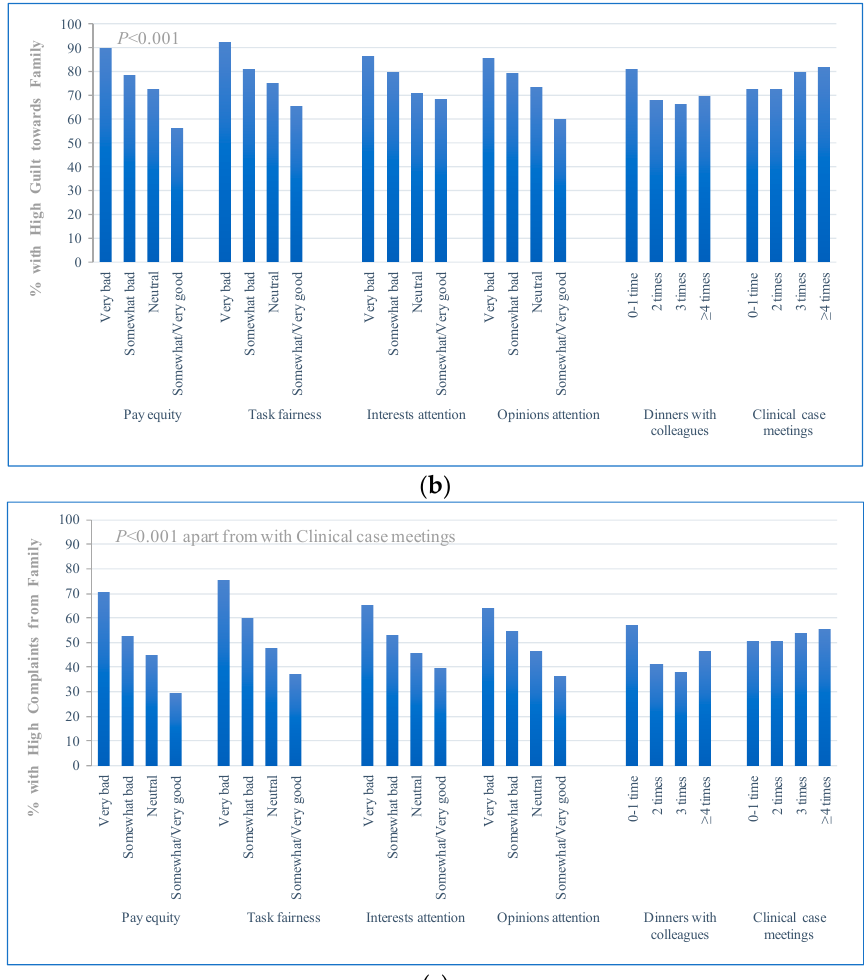
Figure 2. Organizational behavior with work-home conflicts of physician. ( a ) High effect on care for families; ( b ) high guilt towards families; ( c ) high complaints from